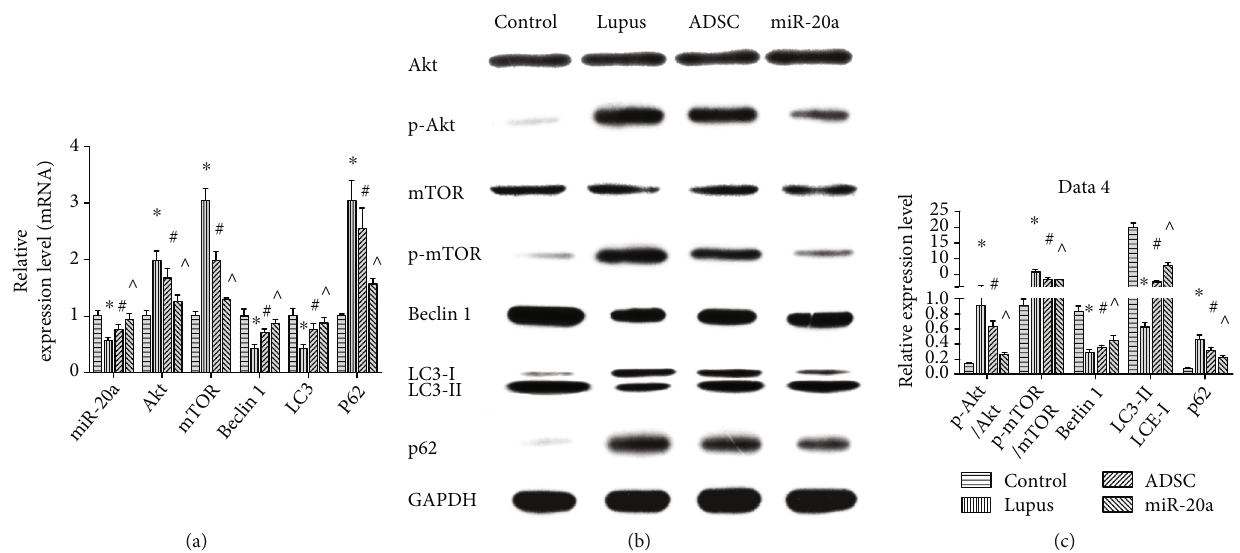
Figure 3: miR-20a-ADSC activates autophagy by inhibiting the miR-20a-related mTOR activation pathway in the kidney of murine LN (Akt, p-Akt, mTOR, p-mTOR, Beclin 1, LC3, and p62). (a) mRNA relative expression levels. (b) Western blot analysis of the expression of proteins in di ff erent groups. (c) The relative protein expression levels. The data are expressed as the mean ± SD . ∗ P < 0 : 05 vs. control group; # P < 0 : 05 vs. lupus group; ^ P < 0 : 05 vs. ADSC group. Control: normal control group; lupus: lupus group; ADSC: adipose-derived stem cell group; miR-20a: miR-20a-ADSC group.